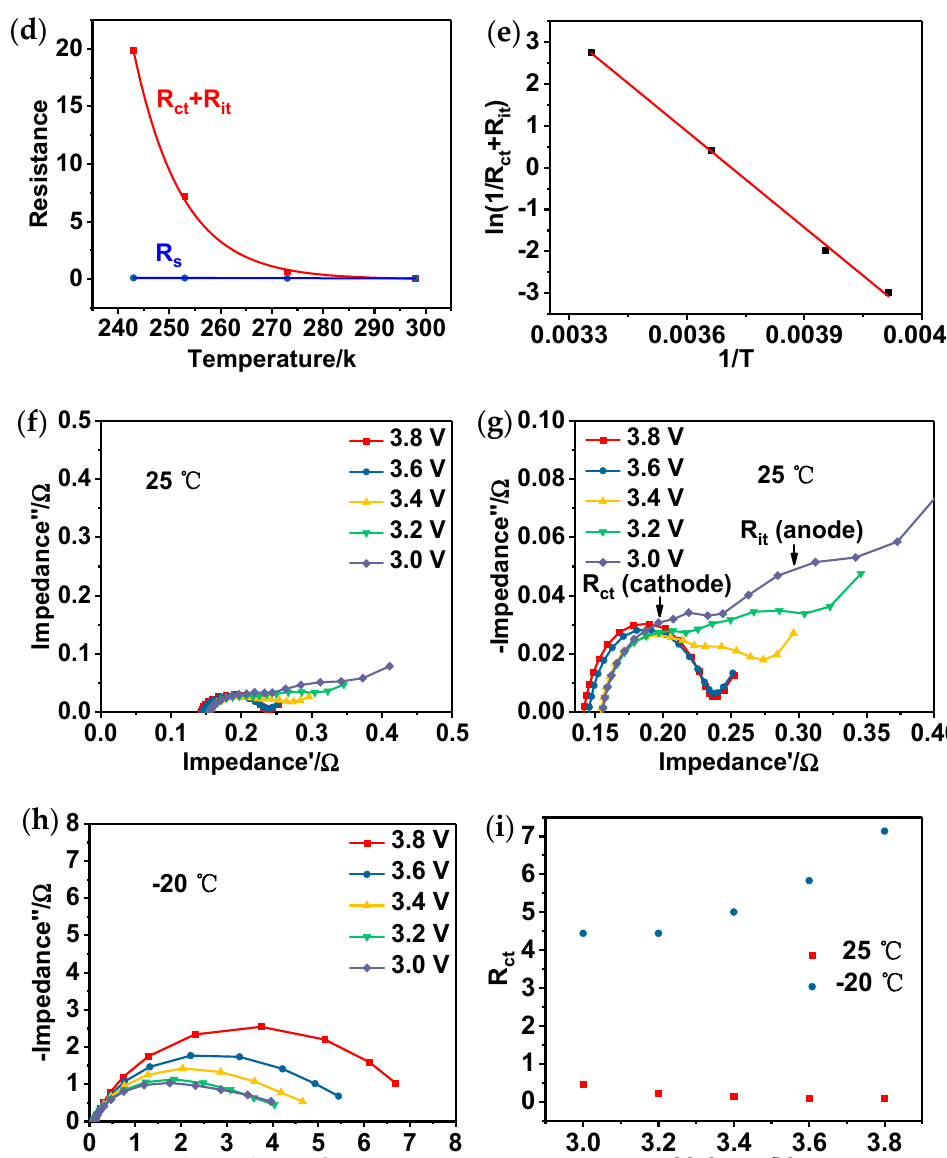
Figure 4. Electrochemical impedance spectroscopy (EIS) and equivalent circuit for normal device: ( a ) schematic diagram and equivalent circuit for normal device; ( b , c ) complex-plane plot of impedance at 25, 0, − 20, and − 30 °C; ( d ) the resistance-temperature plot; ( e ) the ln(1/R ct ) − 1/T plot; ( f , g ) complex-plane plot of impedance at 25 °C; ( h ) complex-plane plot of impedance at − 20 °C; ( i ) the tendency of R ct at different voltages. Table 1. The impedance data of normal devices and symmetrical devices at different temperature and voltage.